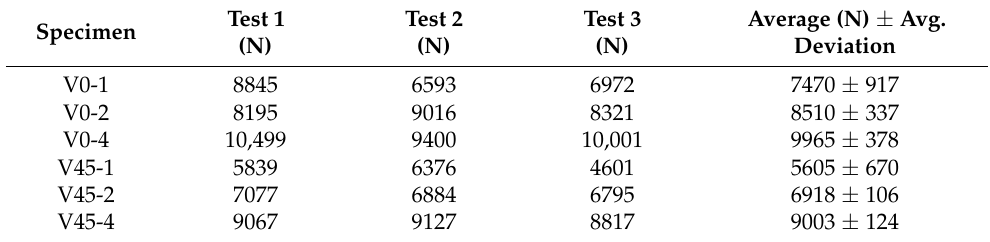
Table 1. Mechanical properties of AA7075-T6, AA6061-T6, and Cu. Table 2. LBC (maximum load) values obtained in the fracture tests of AA7075-AA6061 weld material.